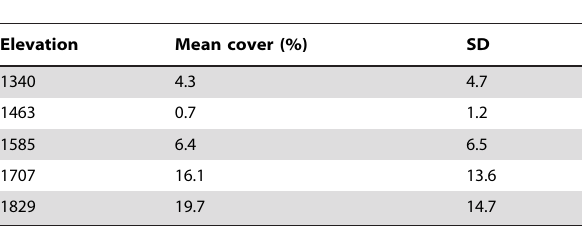
Table 1. Live cover of C. greggii